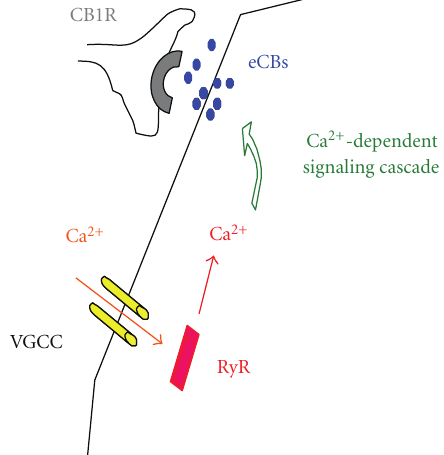
Figure 4: Activation of RyR can provide Ca 2+ to a distant mobiliza- tion site of eCBs away from the Ca 2+ entry